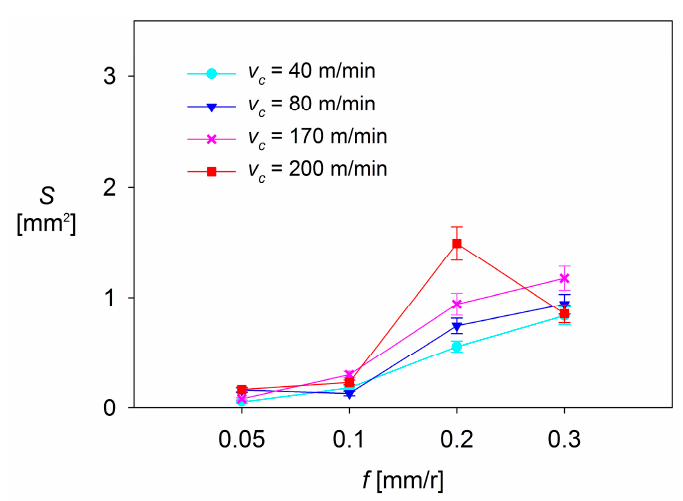
Figure 13. S = f( v c , f ), for a p = 1 mm.